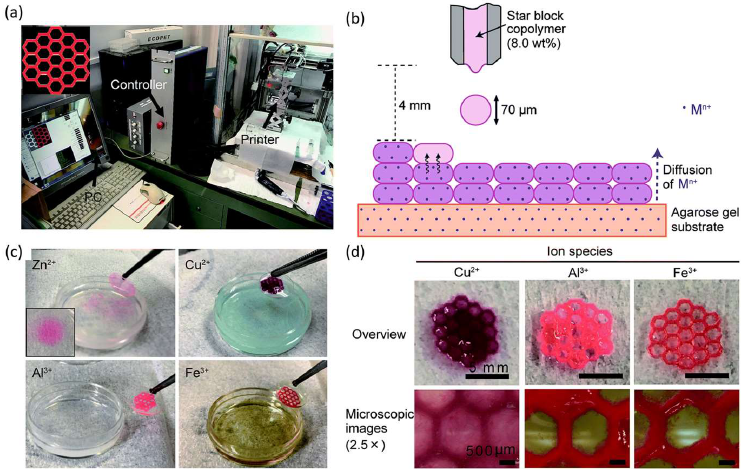
Figure 13. 3D inkjet printing of the star block copolymer hydrogels crosslinked using metallic ions. ( a ) Overview of the inkjet printing system. Inset: horizontal slice of the design of the 3D hydrogel structures that was inputted into the printer. ( b ) Schematic illustration of the printing process. The star block copolymer solution was ejected from the inkjet nozzle towards the agarose gel